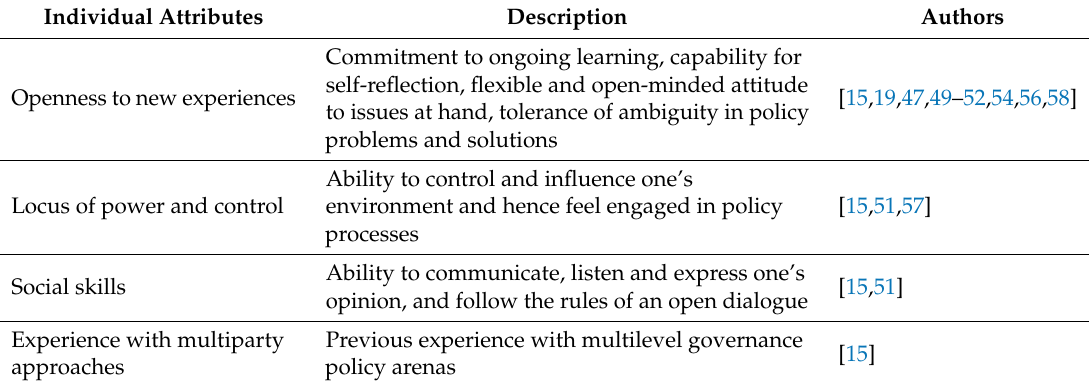
Table 1. Individual attributes influencing the social learning